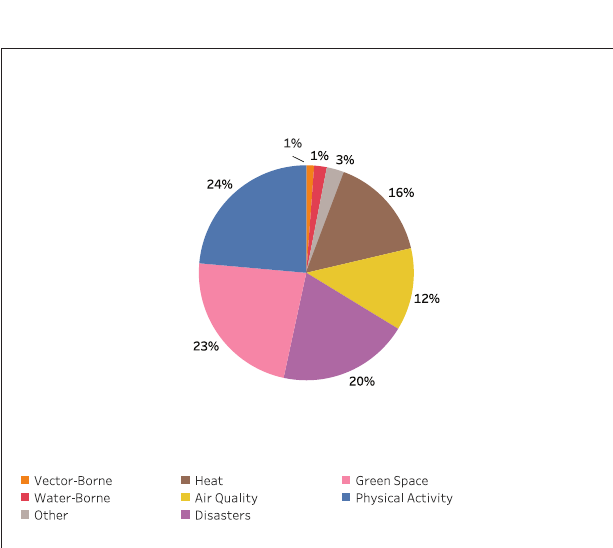
FIGURE 3 | World map of the percentage of identified references related to equity, exposure, health effects, and health co-benefits in 33 CAPs from 27 included cities.